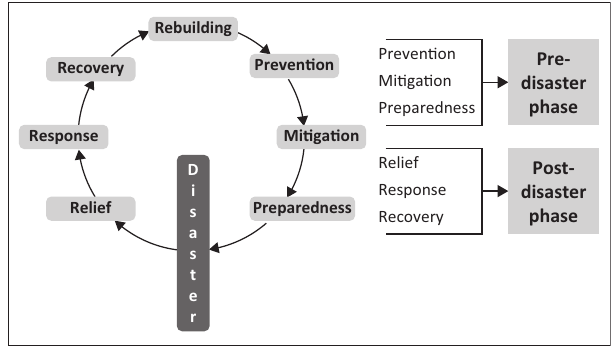
FIGURE 1: Six phases of disaster management